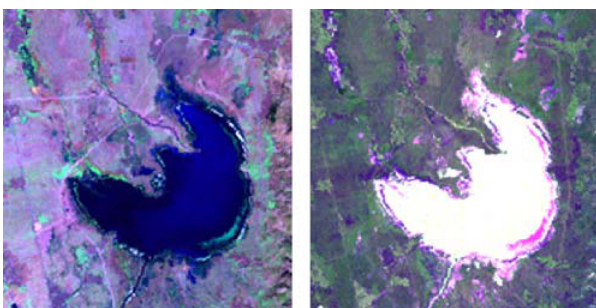
Figure 3. River wetland enhanced results comparison